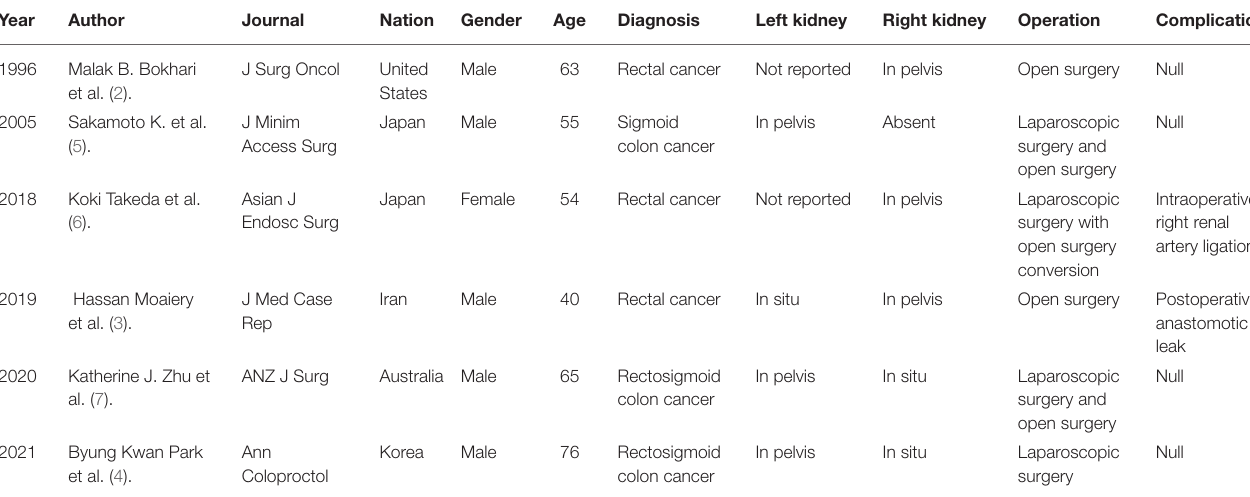
TABLE 1 | Case report of colorectal cancer with pelvic